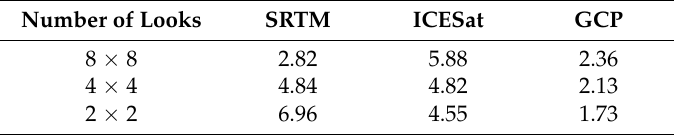
Figure 10. Elevation error map (w.r.t SRTM) with NLs of ( a ) 8 × 8, ( b ) 4 × 4, and ( c ) 2 × 2. We zoom in the rectangular regions of A and B and show the corresponding results in ( d , e ). White regions within the error map are pixels with coherence lower than 0.9. Table 1. RMSEs of TanDEM-X DEM assessed using different kinds of reference data (in unit: meters).